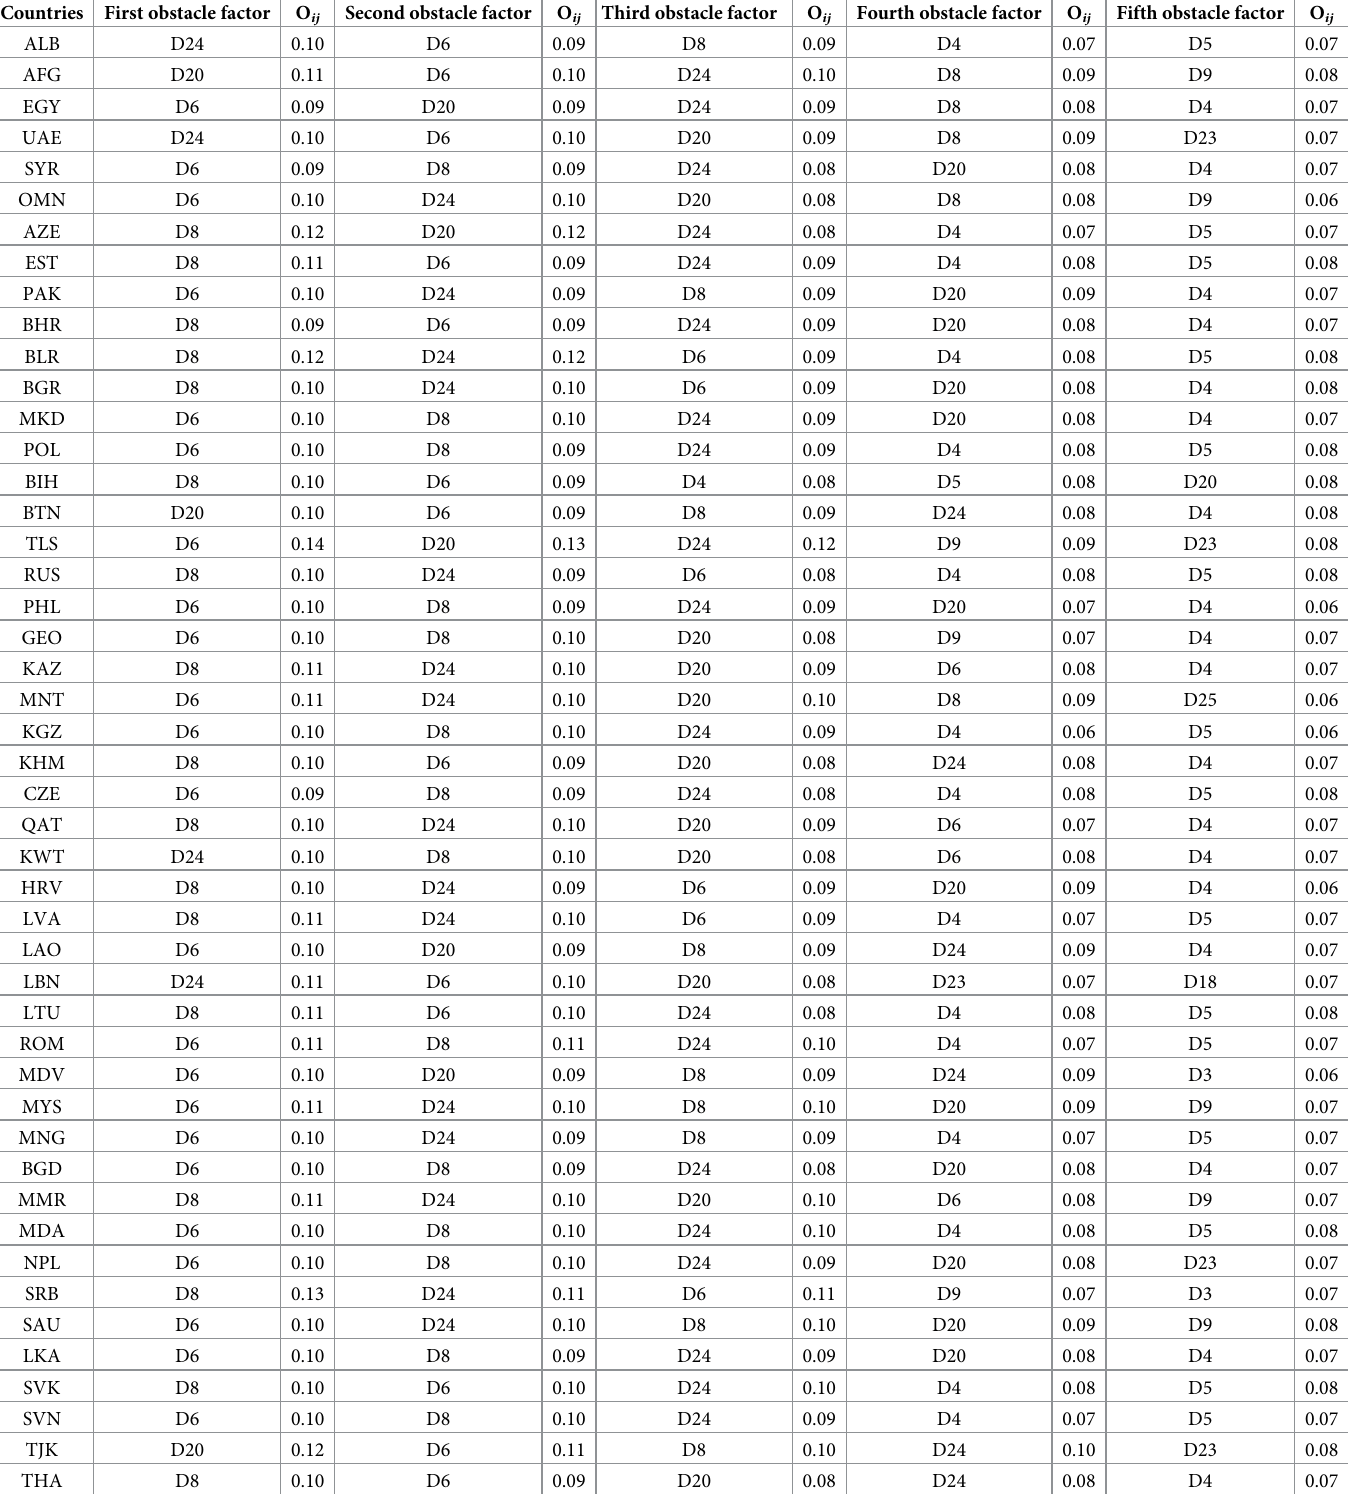
Table 2. Obstacle factor and obstacle degree of integrated economic system of the BRI countries. Countries First obstacle